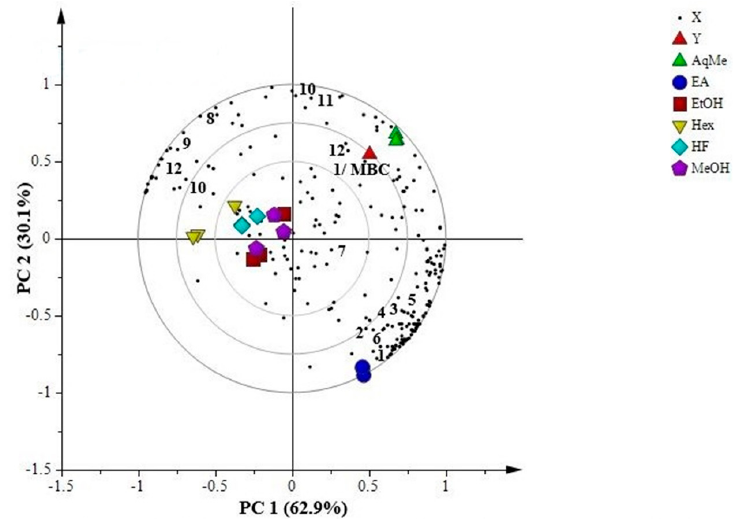
Figure 3. The biplot demonstrates the correlation between extracts and fractions of P. cubeba L. with antibacterial activity of minimum bactericidal concentration (MBC) towards S. sobrinus . MeOH: